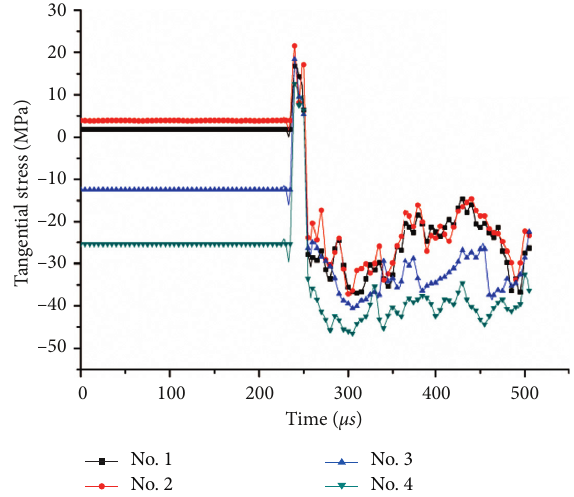
Figure 9: Changes in stress at calculated points under the action of the combined stress